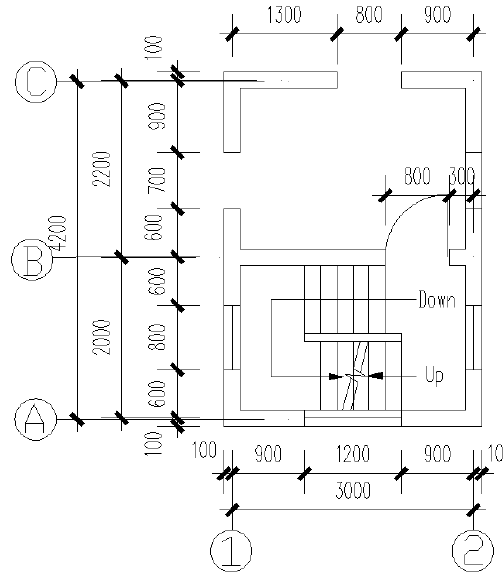
Figure 1. Plan of the test model.